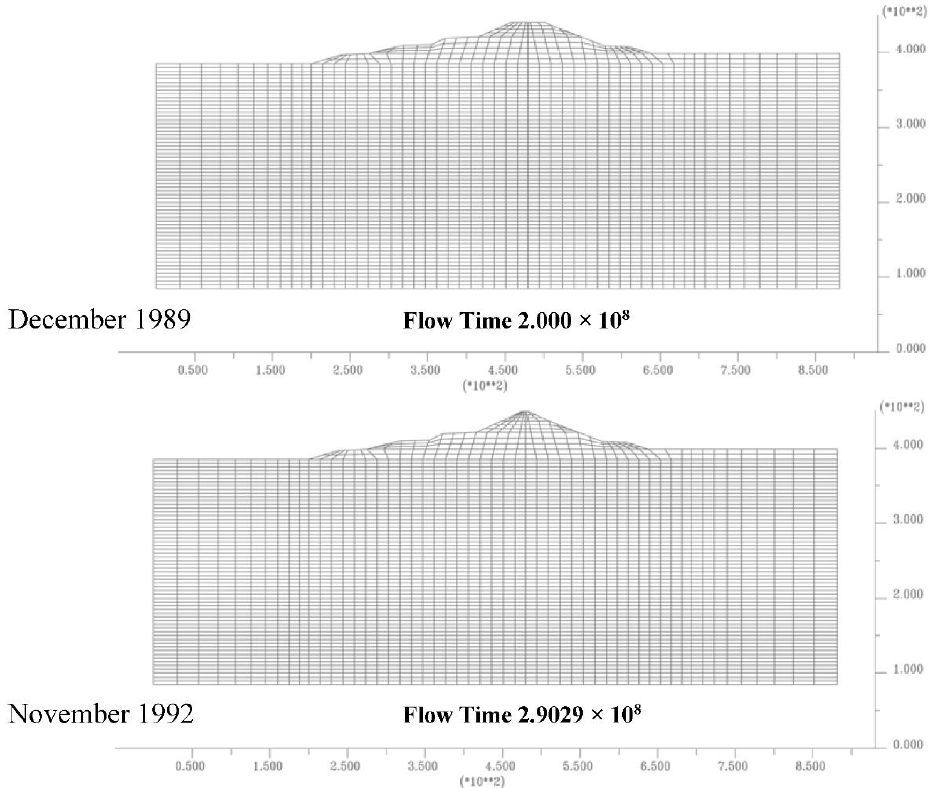
Figure 21. Dam’s construction steps implemented, dam realization.